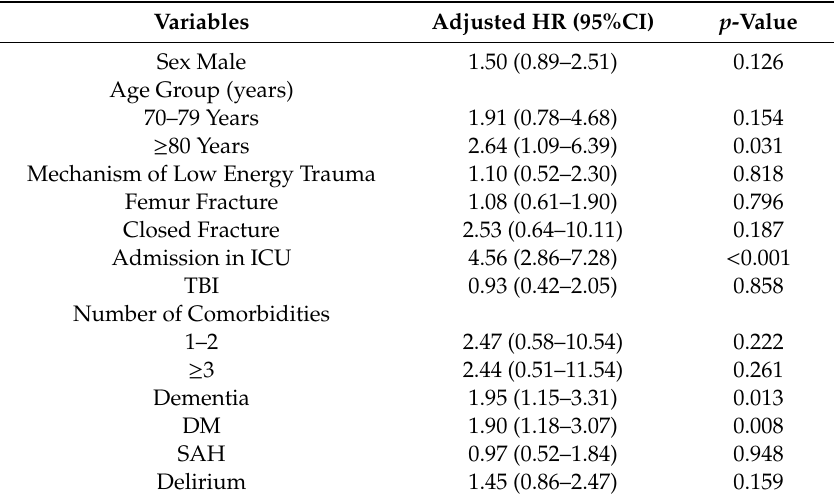
Table 4. Regression analysis of the factors associated with survival in the fractured elderly admitted to an emergency hospital in Goi â nia, Central Brazil (2016 /